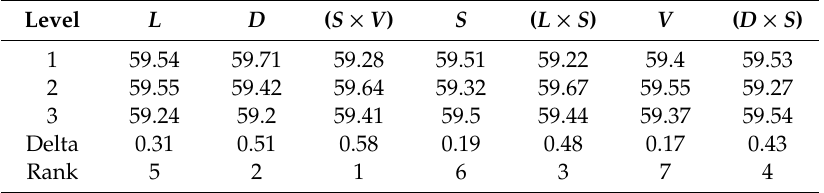
Table 4. E ff ect of laser cladding process parameters on the micro-hardness of the coatings ( S / N ratio).